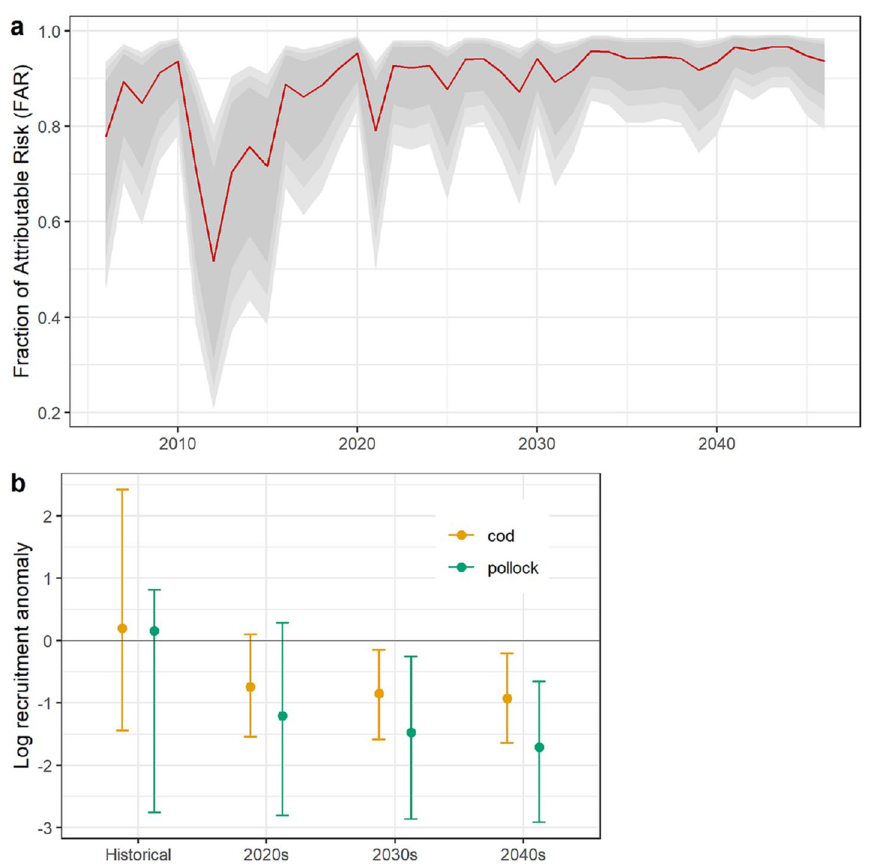
Figure 5. Historical and forward-looking predictions of cod and pollock recruitment. ( a ) Bayesian time series modeling of CMIP5 projected FAR values under RCP8.5, 2006–2046. Red line indicates predicted FAR value, with grey ribbons indicating 80/90/95% CI due to model uncertainty. ( b ) Predicted cod and pollock recruitment based on historical observed FAR values (1970–2019 for pollock, 1977–2019 for cod) and current/future decades under CMIP5 RCP8.5 FAR projections: median values with 95%